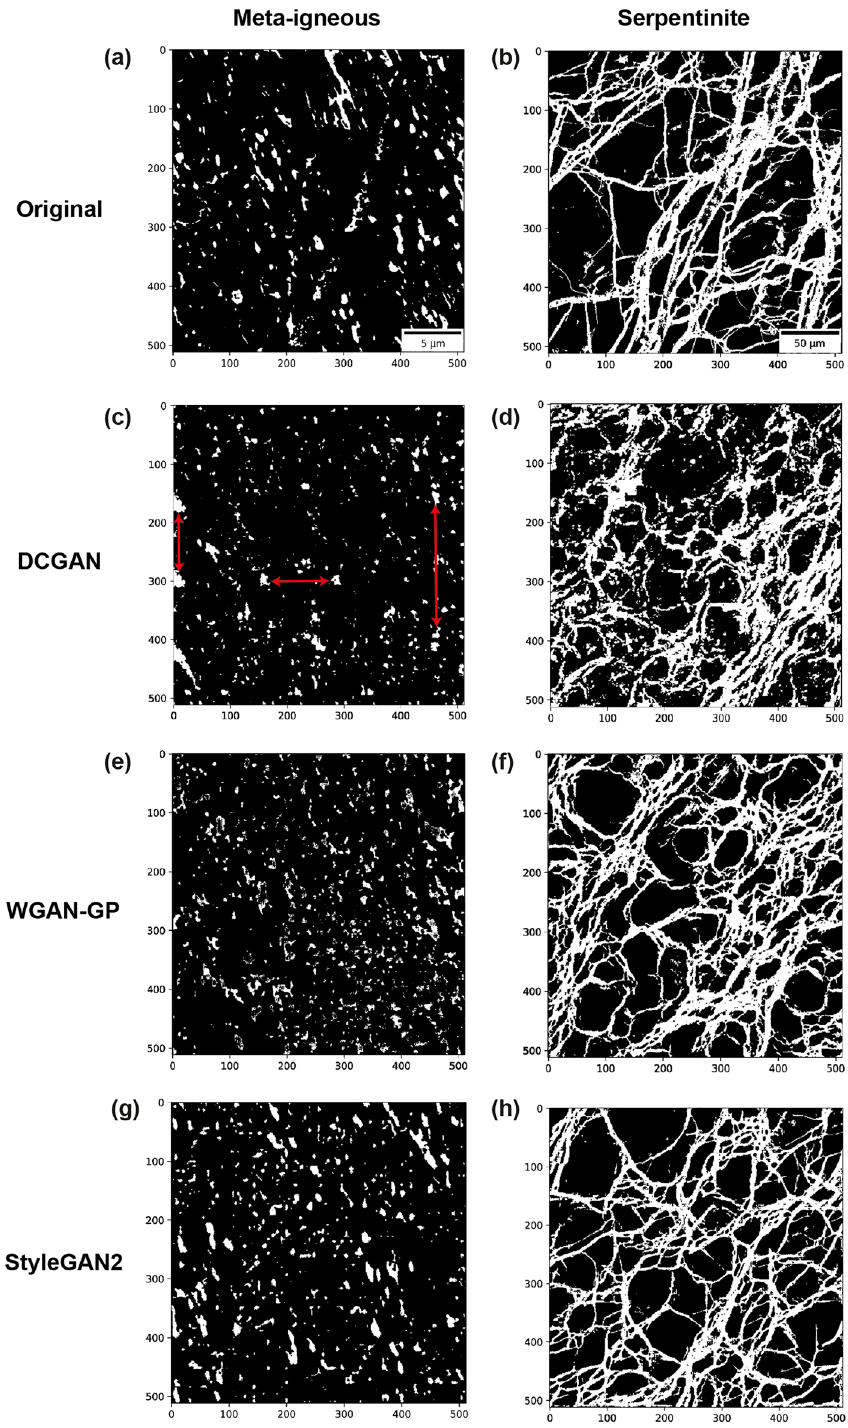
Figure 6. Examples of image reconstructions of meta-igneous (first column) and serpentinite (second column) with representative size using GAN models. ( a , b ) Original microstructure, ( c , d )